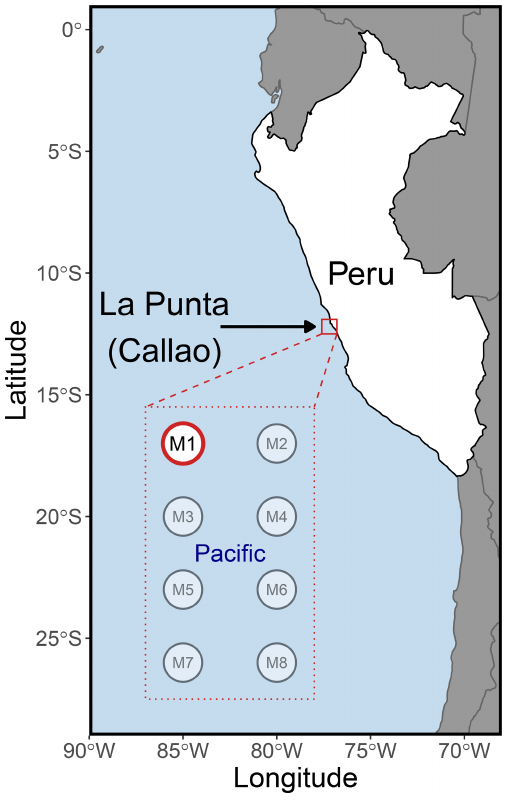
Figure 1. The KOSMOS 2017 study site. The eight mesocosms (M1–M8) were deployed 6km offshore of La Punta (Callao), just north of Isla San Lorenzo (12.0555 ◦ S; 77.2348 ◦ W). All meso- cosms were sampled for chl a , various biogeochemical variables, and multiple physicochemical parameters (Bach et al., 2020). Meso- cosm M1 (highlighted in red) was also analyzed for DNA and flow cytometry, as was the nearby unenclosed Pacific Ocean. Please note that the square marking the study site is not true to